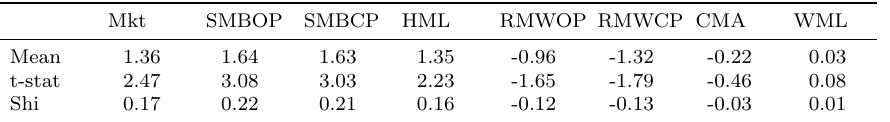
Table 2: Descriptive Statistics of